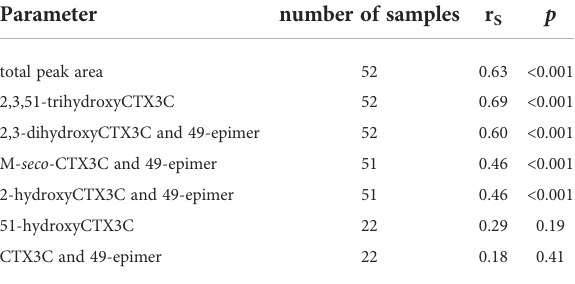
TABLE 1 Spearman ’ s rank order coef fi cient (r S ) calculated for composite toxicity (determined by N2a-bioassay) and peak areas (LC-MS/MS).